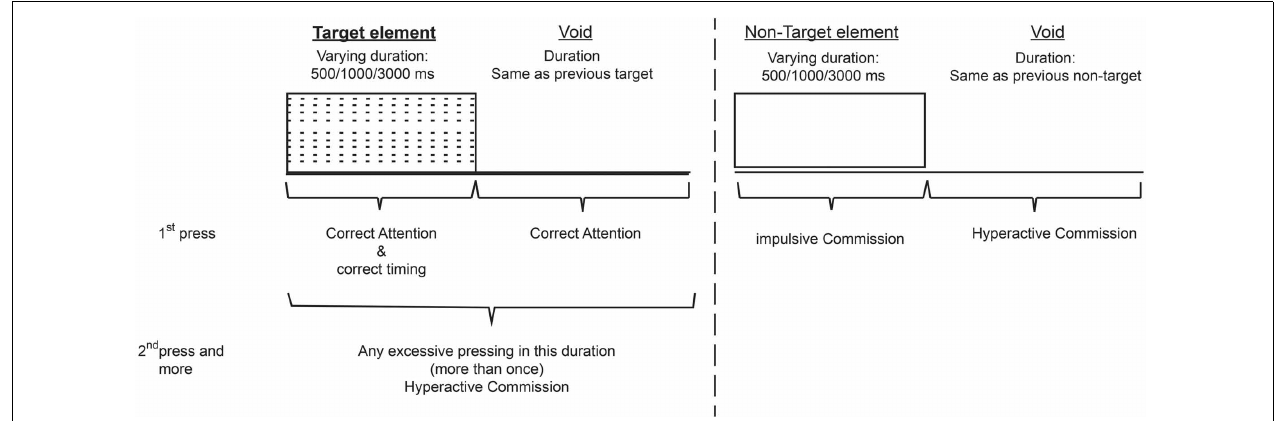
FIGURE 1 | Definition of the time line- Target and non-target stimuli were presented for 500, 1000, or 3000ms. Each stimulus was followed by avoid period of the same duration. The stimulus remained on the screen for